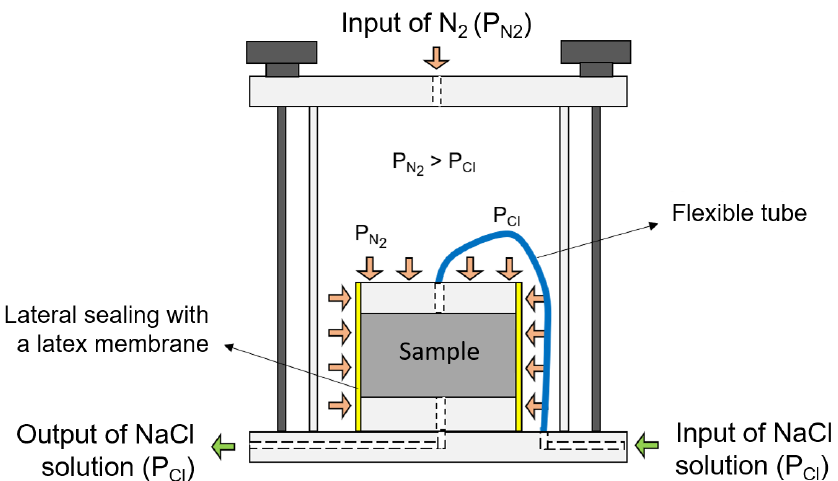
Figure 6. Schematic drawing of internal operation of the